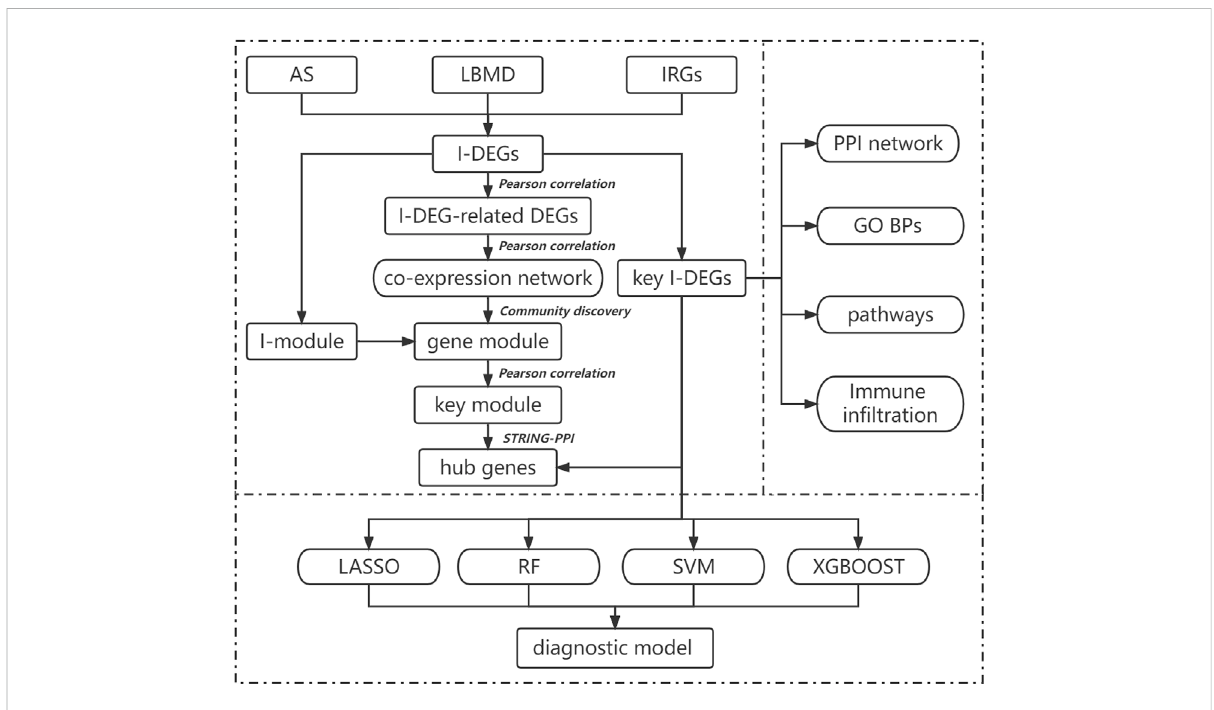
FIGURE 1 Flow-chart of datasets analysis in this paper.